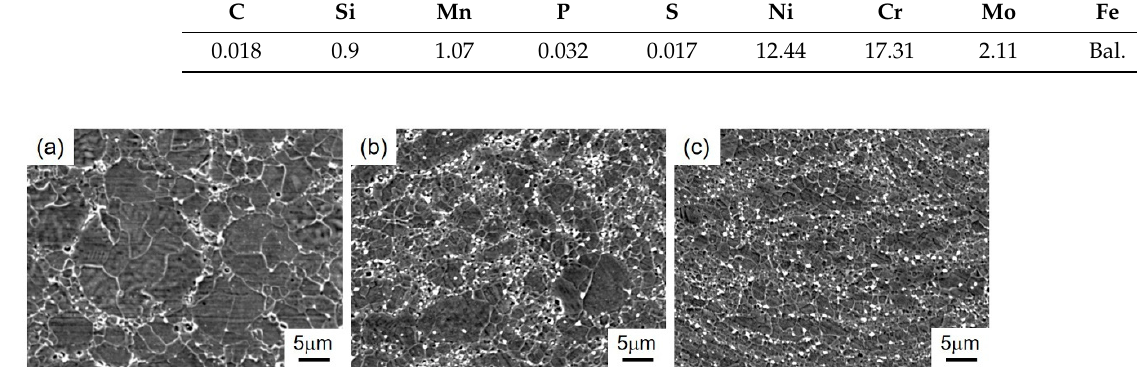
Figure 2. Microstructure of sintered SUS316L compacts: ( a ) MM0h compact; ( b ) MM10h compact; ( c ) MM30h compact. Table 2. Grain size of harmonic-structured SUS316L